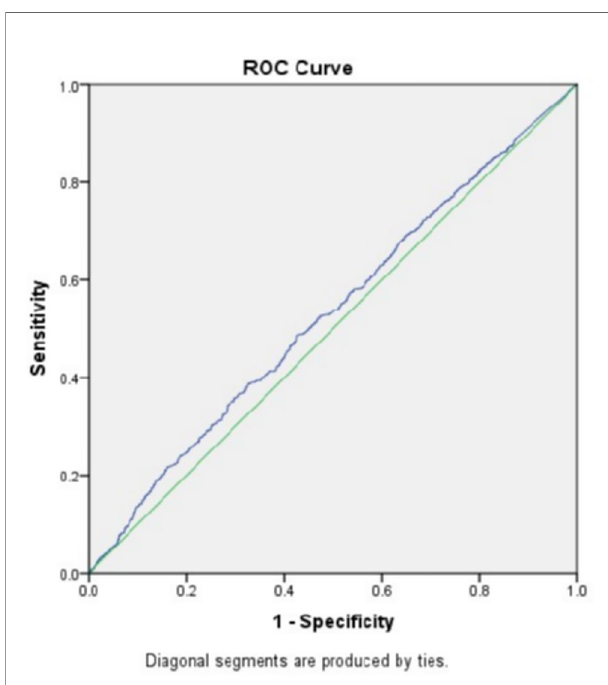
FIGURE 1 | Receiver-operating characteristic (ROC) curve analysis for AMH as a predictor of